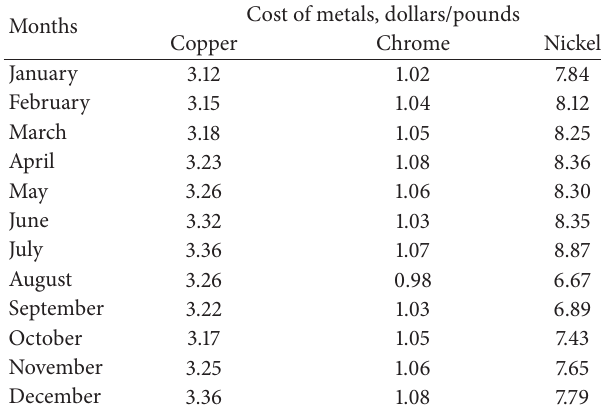
Table 3: Analysis of copper, chromium, and nickel prices in US dollars